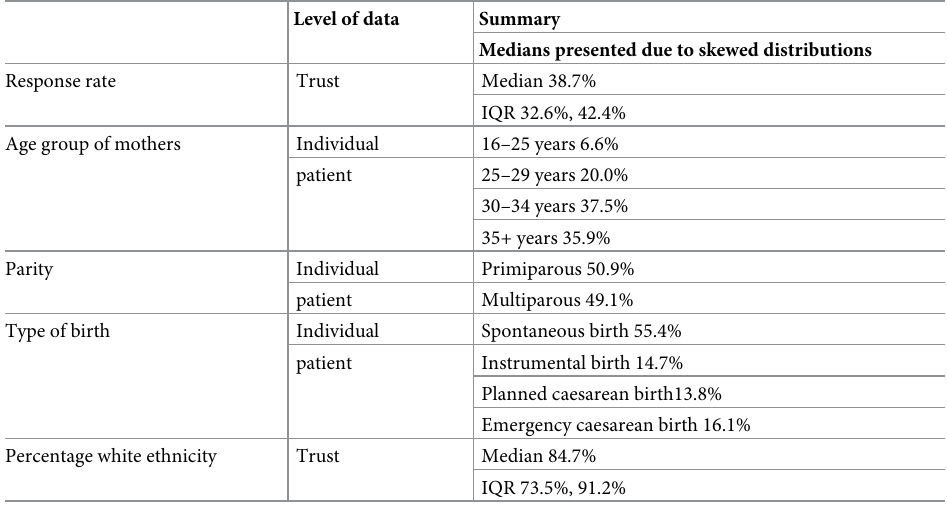
Table 2. Data characteristics for respondents in maternity survey.